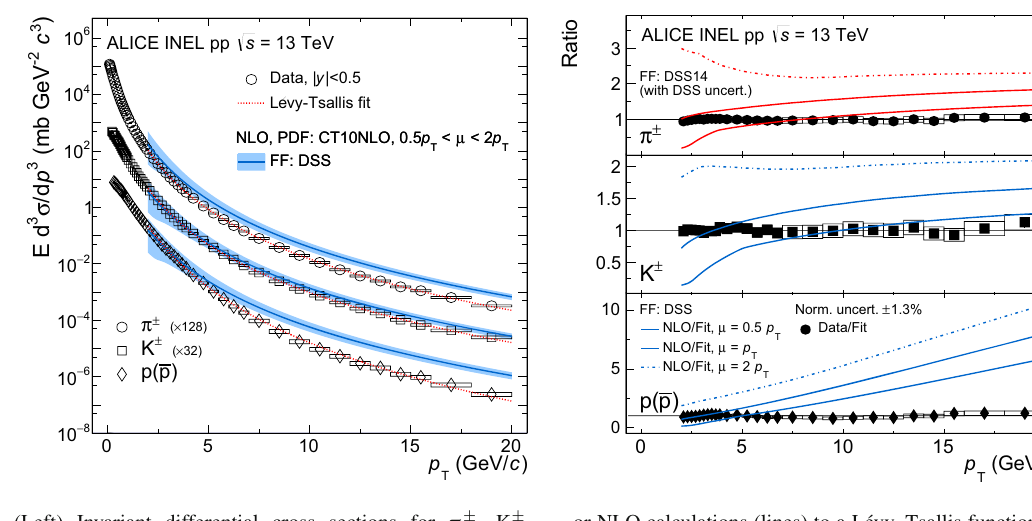
or NLO calculations (lines) to a Lévy–Tsallis function that is fitted to the data. The NLO-to-fit ratio is shown for the scale μ = p T and the variations μ = p T / 2 and μ = 2 p T . The fully correlated normalization uncertainty is indicated in the legend